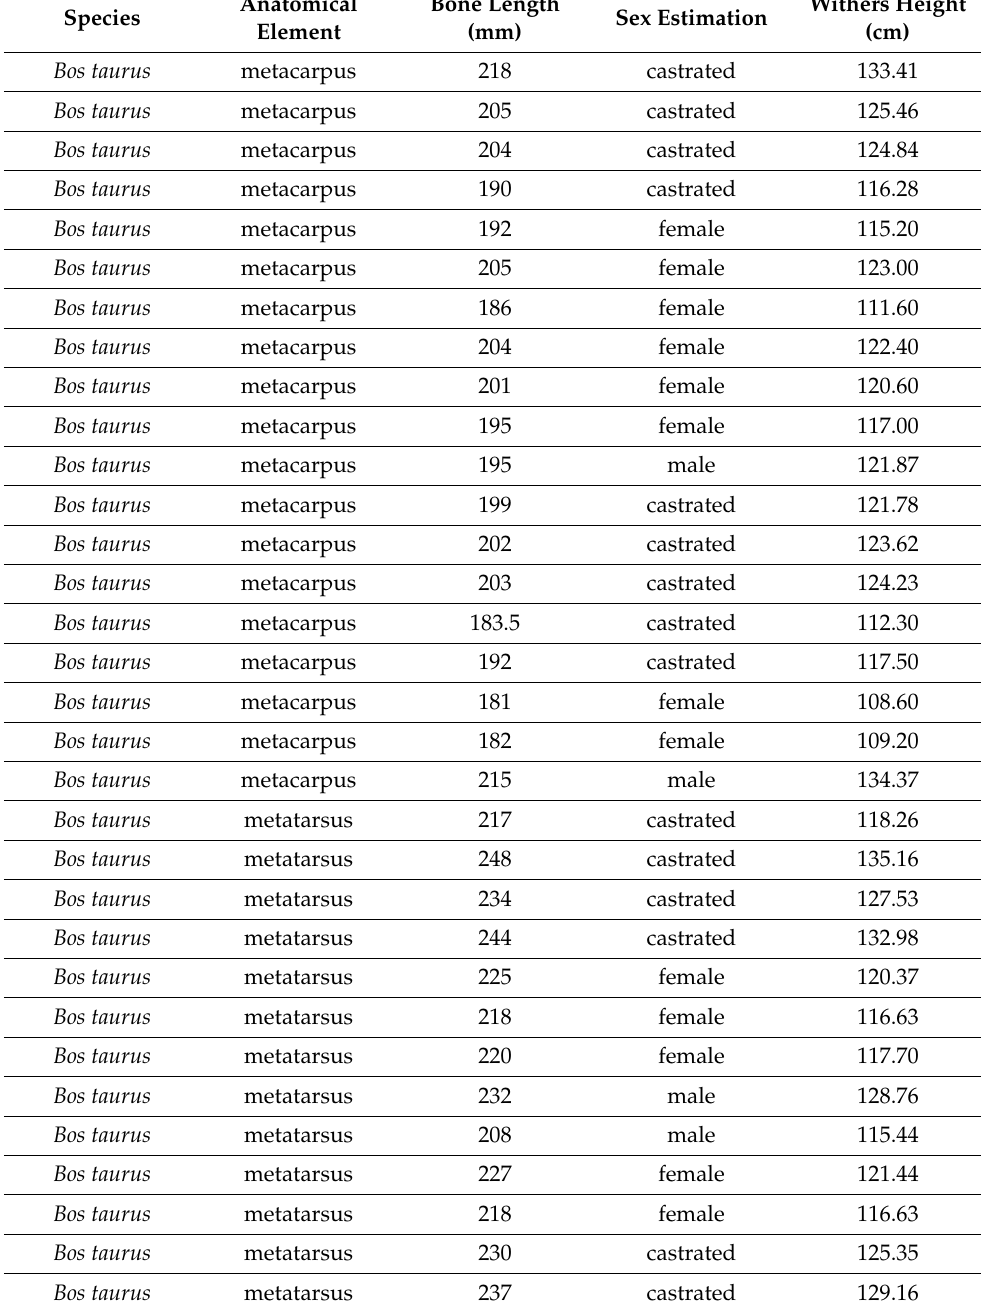
Table 6. Halmyris, Romania, 2014, extramuros area (4th–6th centuries AD). Estimations of withers height and sex based on osteometric data (used coefficients as follows: Fock [58] for Bos taurus , Teichert [59] for Ovis aries , Schramm [60] for Capra hircus , Teichert [61,62] for Sus domesticus and Sus scrofa , and Harcourt [63] for Canis familiaris